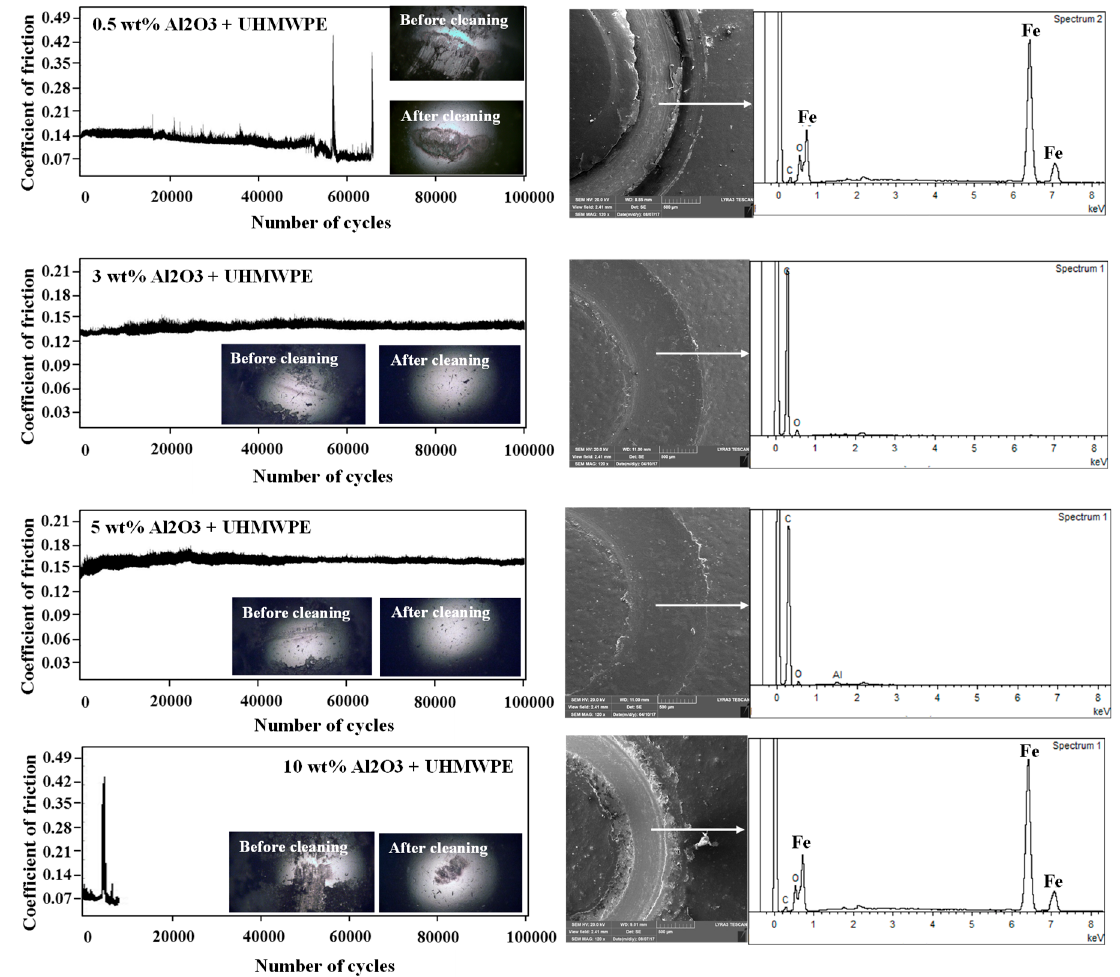
Figure 8. Typical frictional graphs, FESEM/EDS spectrums of the wear track, counterface ball images before and after cleaning, after a sliding wear test conducted on the nanocomposite coatings with different loadings (0.5, 3, 5, and 10 wt %) of alumina at normal load of 12 N and at a sliding speed of 0.1 m/s.